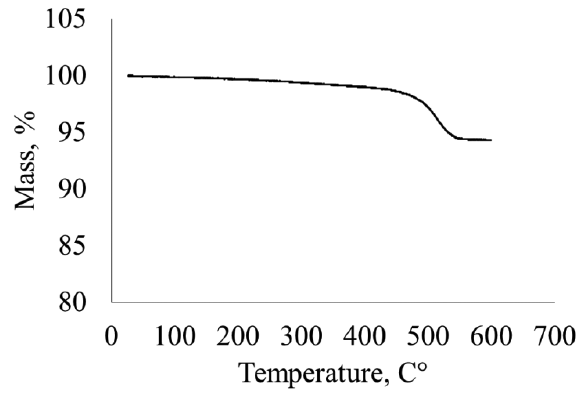
Figure 6: TG thermogram of solid product obtained at 110°C for 5